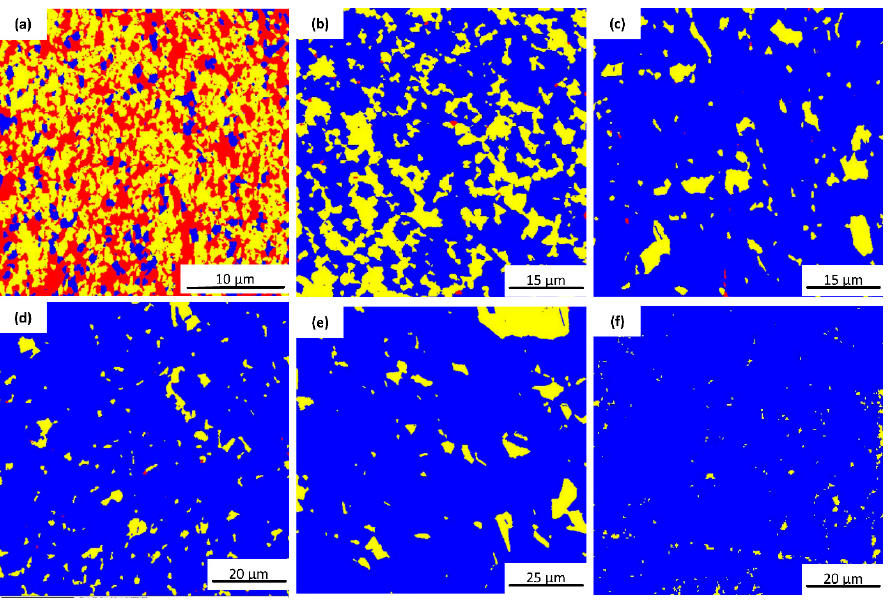
Figure 7. The recrystallization fractions at different annealing temperatures: ( a ) 160 °C; ( b ) 200 °C; ( c ) 240 °C; ( d ) 280 °C; ( e ) 320 °C; and ( f ) 360 °C .